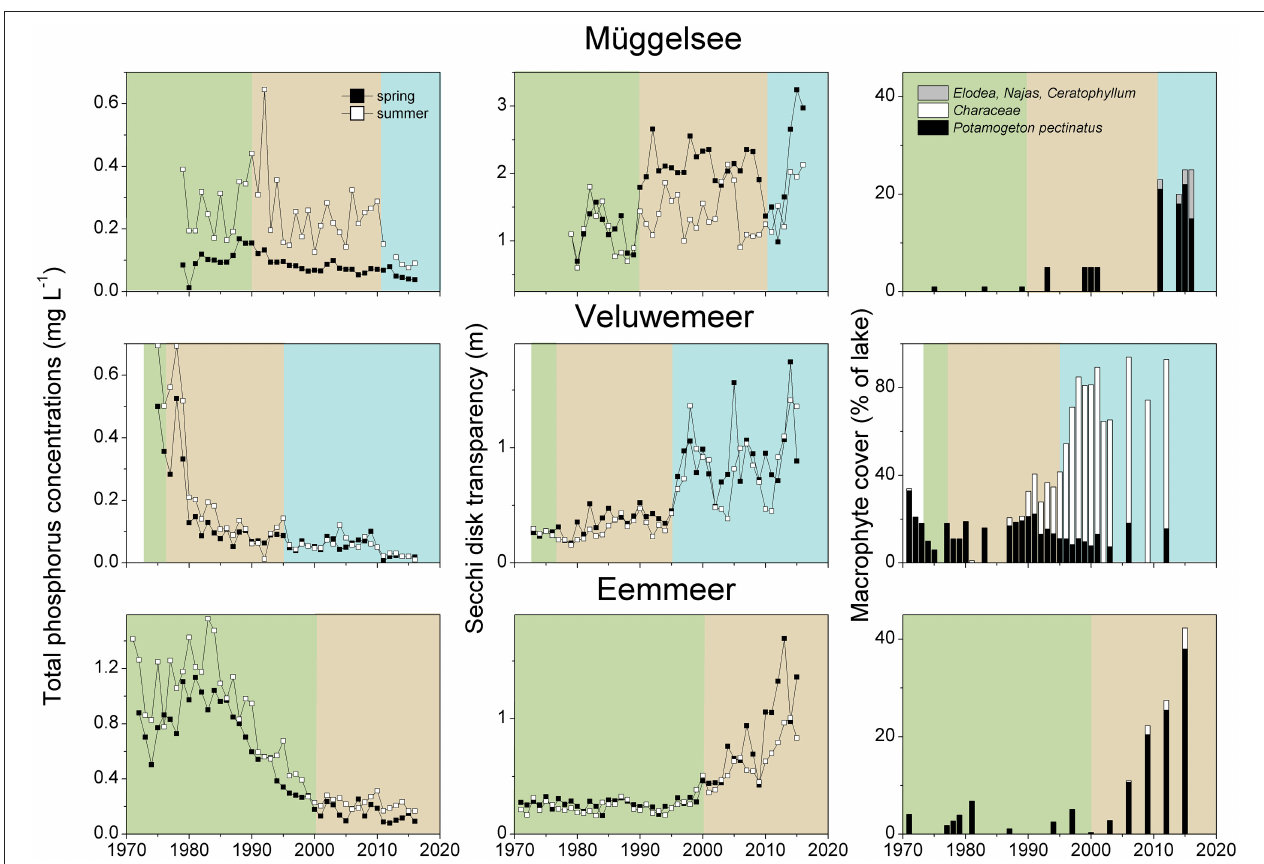
FIGURE 3 | Total phosphorus (TP) concentrations and Secchi depth in spring (April–June) and summer (July–September) and macrophyte coverage in Lake Müggelsee; Lake Veluwe and Lake Eem during the turbid (green), the intermediate recovery (brown) and the clear-water (blue) state (for lake details see Table 1